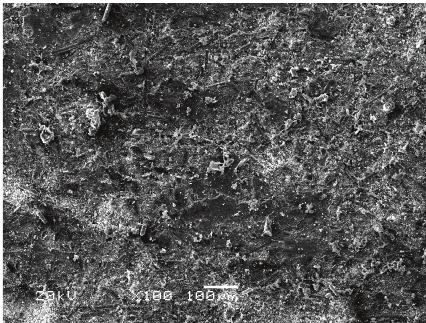
Figure 8: SEM picture of the surface containing micro-convex- apices.